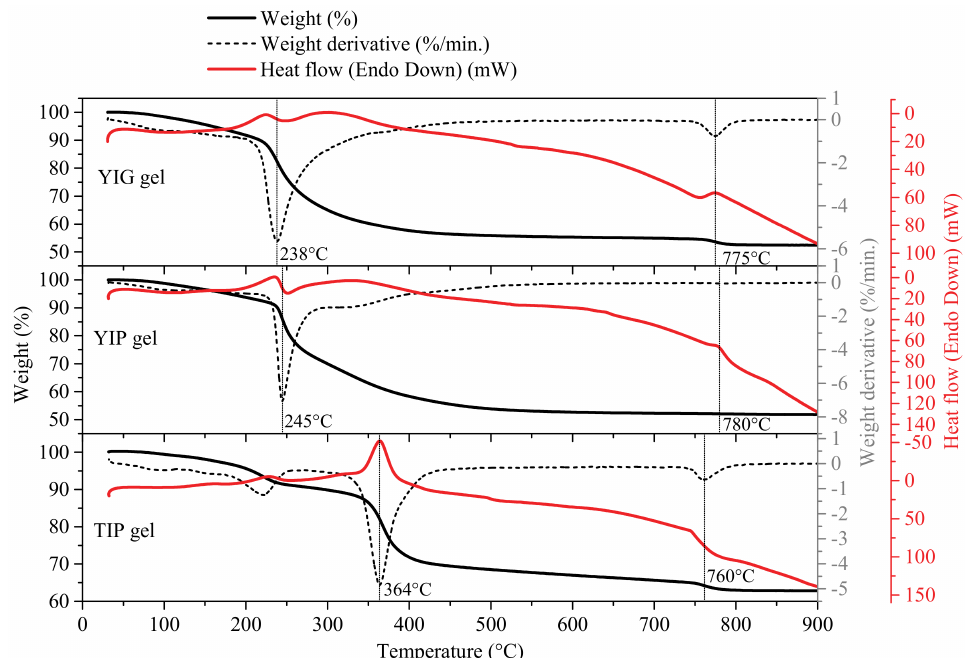
Figure 1. TG/DTG/DSC curves of indicated gels.